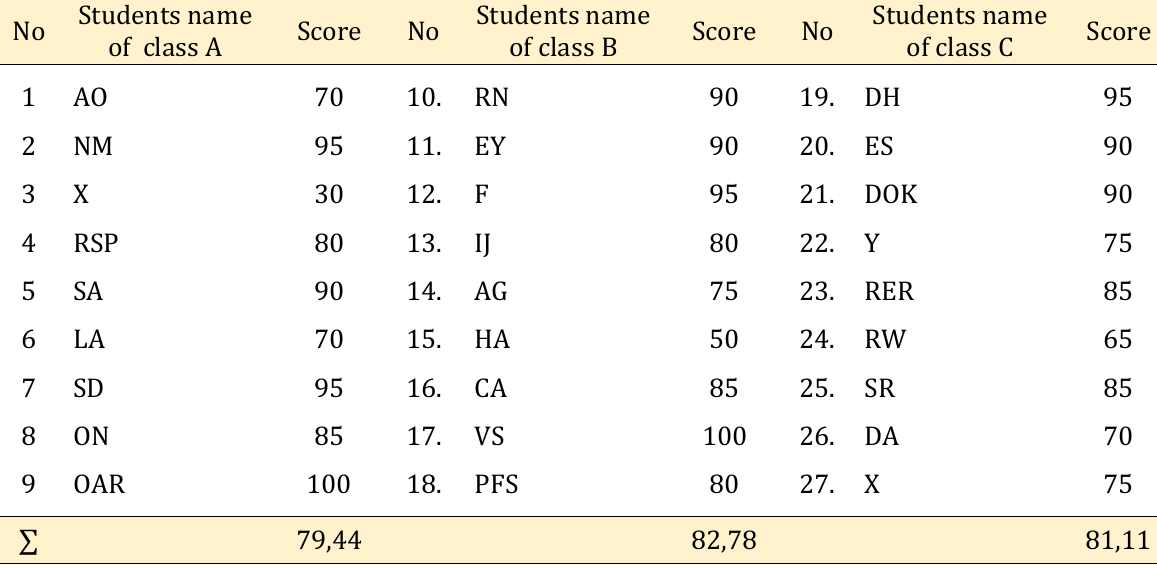
Table 4. Table II. Score of Argumentative